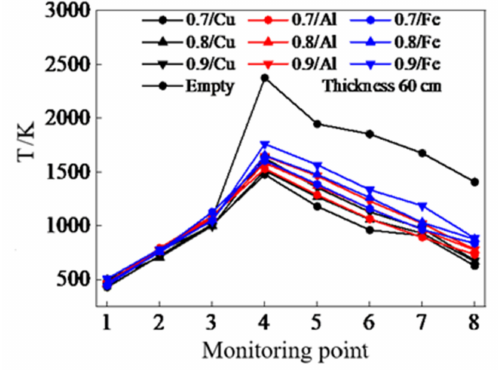
Figure 19. Maximum temperature at each monitoring